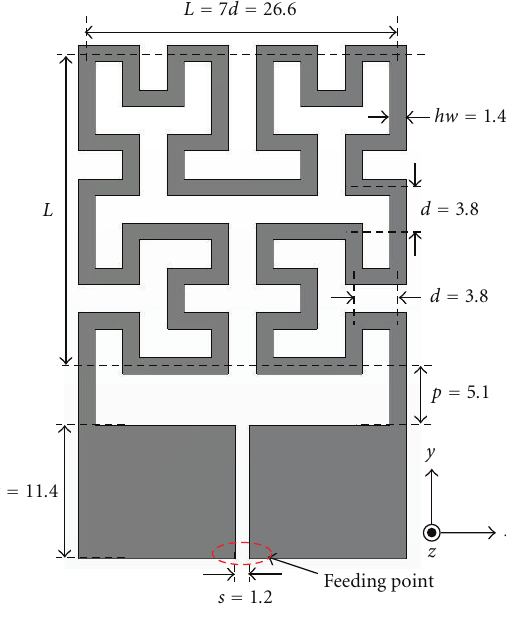
Figure 2: Geometry and dimensions of the proposed Hilbert-curve loop